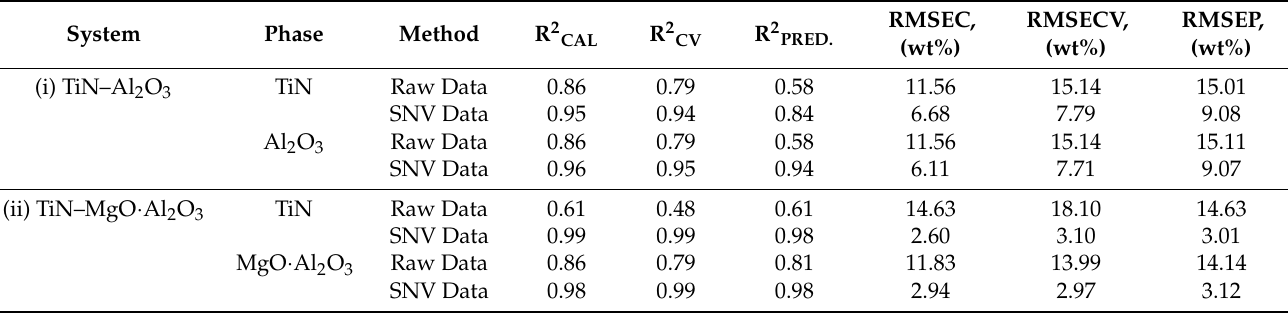
Table 5. Estimated figures of merit for calibration and validation using the PLS models for (i) TiN–Al 2 O 3 and (ii) TiN– MgO · Al 2 O 3 . System